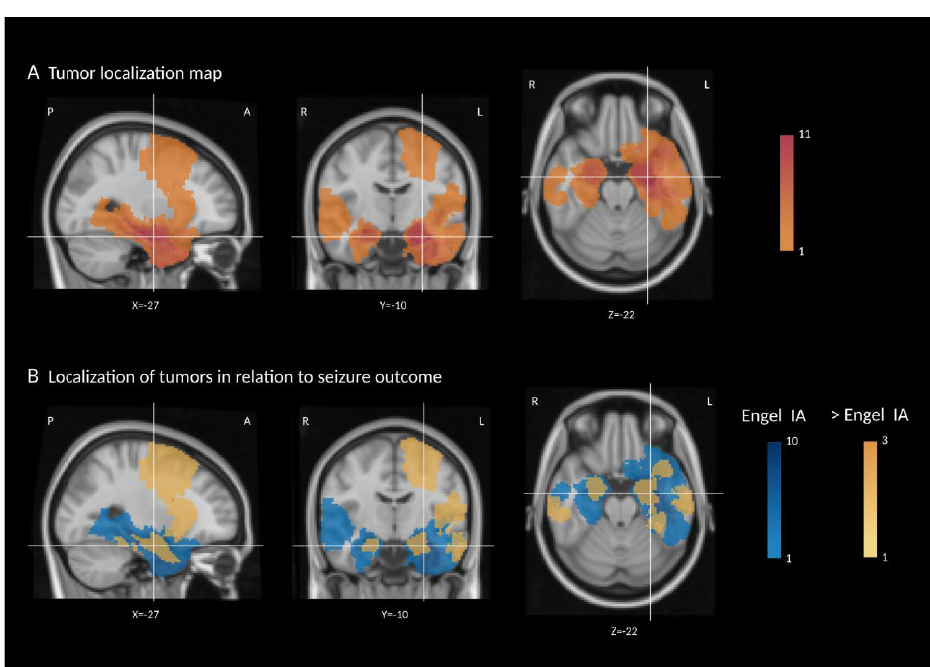
Figure 1. ( A ) Tumor localization map — summed segmentation masks of all patients overlaid on the standard brain image (MNI). The legend refers to the number of patients with tumor tissue in a voxel, with darker red indicating a higher number of patients. ( B ) Localization of tumors in relation to seizure outcome. Patients were divided into two groups according to their postoperative seizure outcome, and the respective segmentation masks were summed. Legends refer to the number of patients with tumor tissue in a voxel, with darker blue indicating a higher number of patients with outcome Engel IA and darker orange a higher number of patients with outcome > Engel IA. X, Y, and Z represent MNI space coordinates for the given slice. L = left, R = right, A = anterior, and P = posterior.